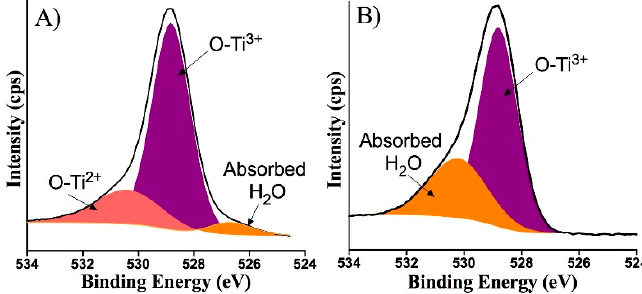
Figure 5. Narrow scan XPS spectra of O 1s region in ( A ) undoped and ( B ) Eu-doped TiOx thin films.